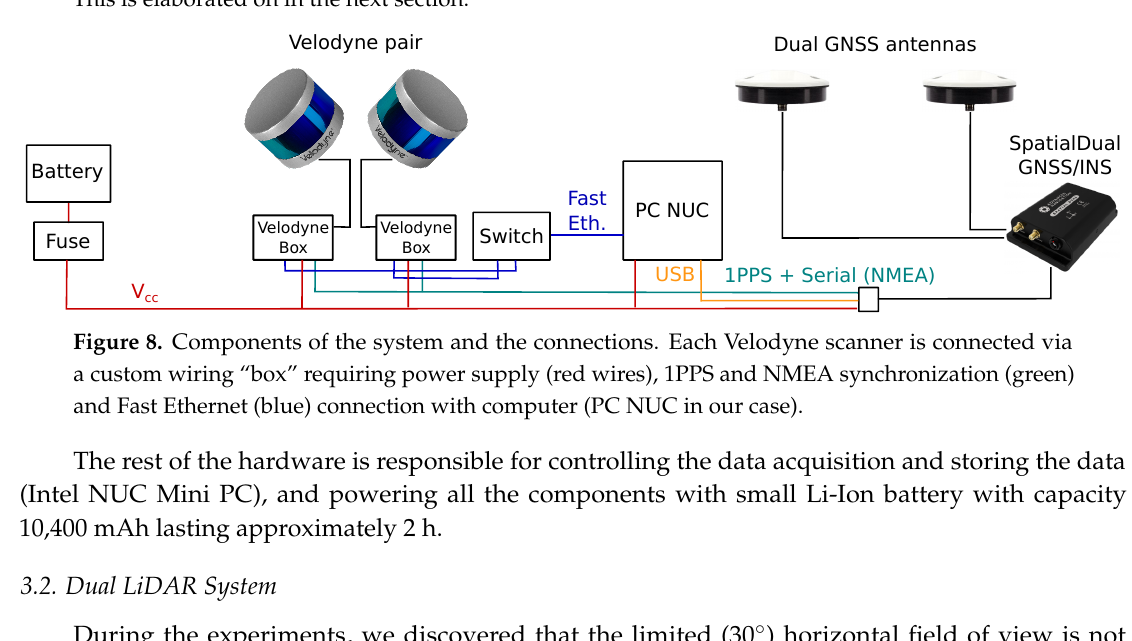
Figure 7. The initial ( a ) and improved ( b , c ) prototype of our backpack mapping solution for both indoor ( b ) and outdoor ( c ) use. The removable dual GNSS antenna provides precise heading information, aiding for outdoor odometry estimation and also georeferencing of the resulting 3D point cloud model. It should be noted that the position of LiDAR scanners is different in the initial and the later solution. This is elaborated on in the next section.